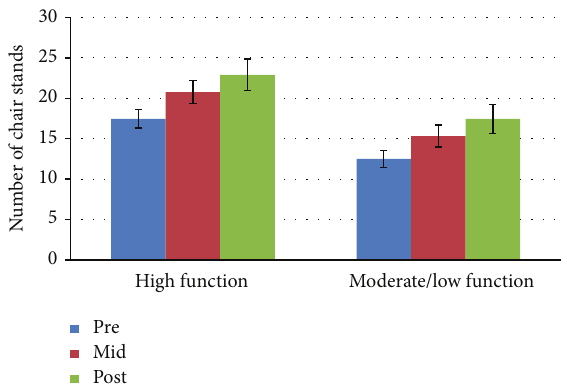
Figure 1: Chair Stand Test mean scores by group and time.